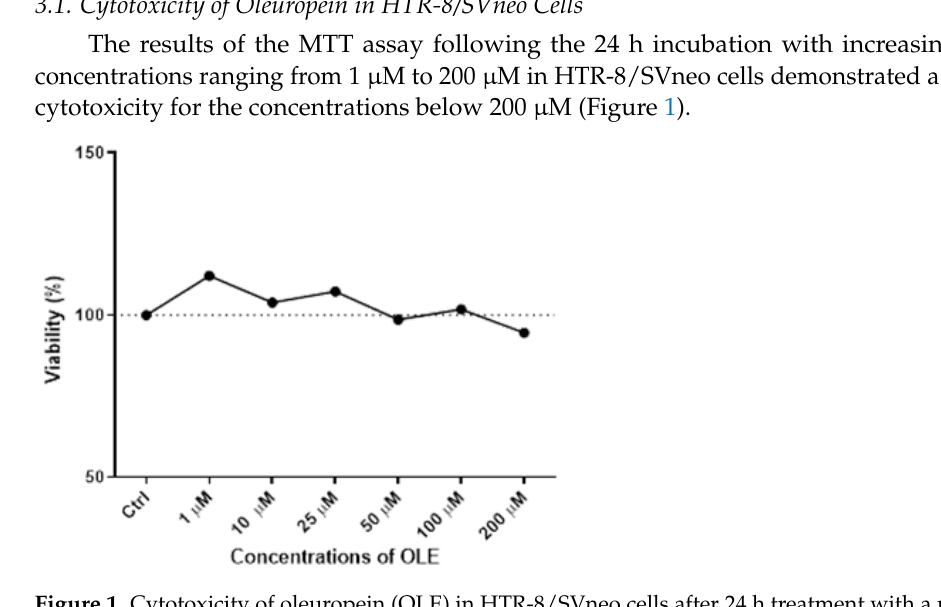
Figure 1. Cytotoxicity of oleuropein (OLE) in HTR-8/SVneo cells after 24 h treatment with a range of concentrations (1, 10, 25, 50, 100 and 200 µM).